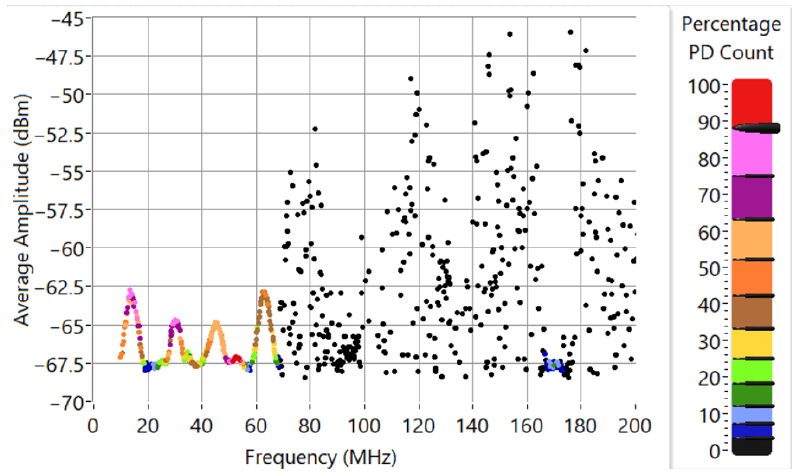
Figure 6. An illustrative example of the proposed FRPD